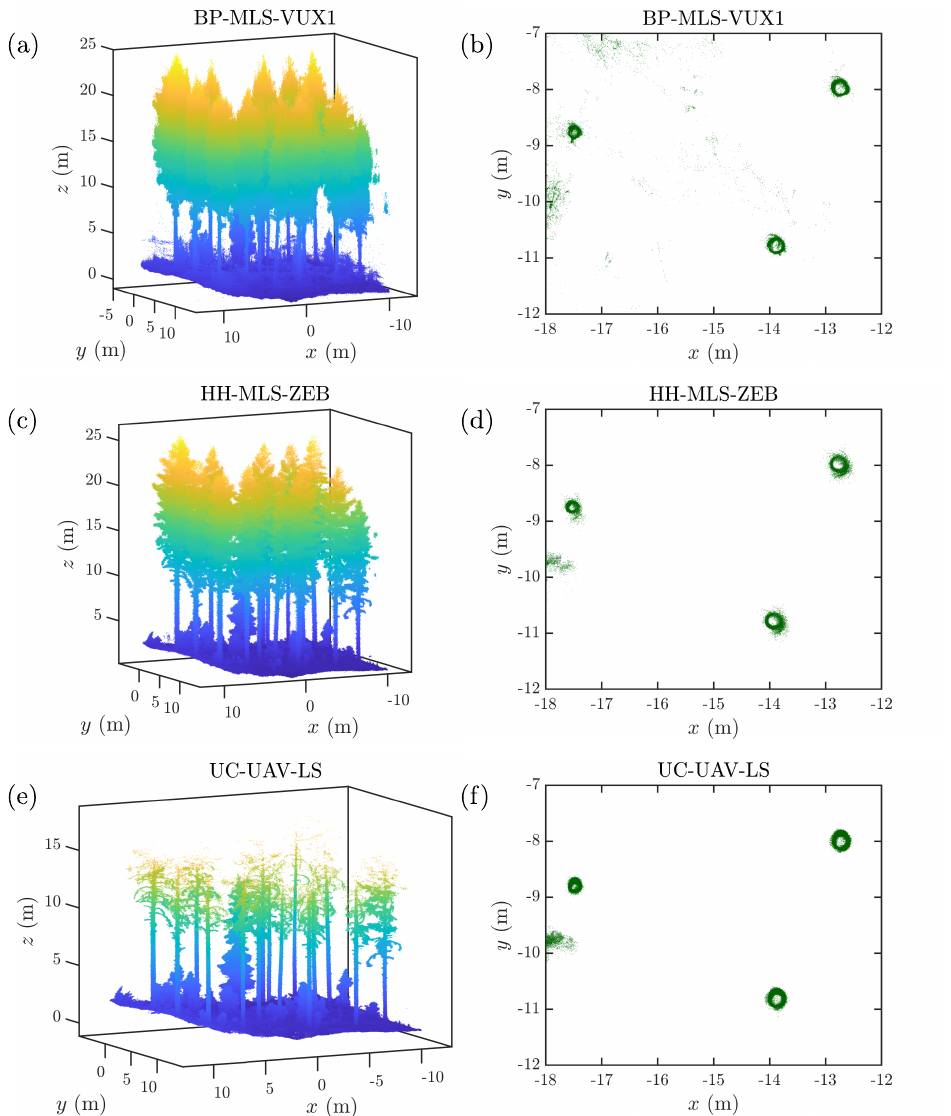
Figure 5. ( a , c , e ) Simultaneous localization and mapping (SLAM)-corrected point clouds from a 20 m × 20 m region within the sparse plot collected with ( a ) the backpack BP-MLS-VUX1 system, ( c ) the handheld HH-MLS-ZEB system, and ( e ) the under-canopy UC-UAV-LS system. ( b , d , f ) Cross sections of the SLAM-corrected point clouds in the height interval z ∈ [ 2 m,3 m ] showcasing the stems of three pine trees in the point cloud collected with ( b ) the BP-MLS-VUX1 system, ( d ) the HH-MLS-ZEB system, and ( f ) the UC-UAV-LS